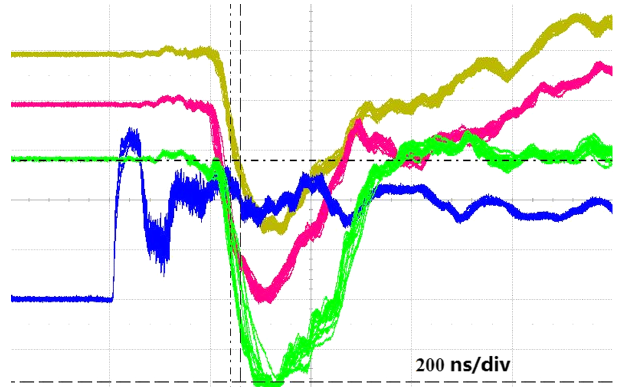
FIG. 17. Experimental output waveforms of the trigger system (ten consecutive shots).